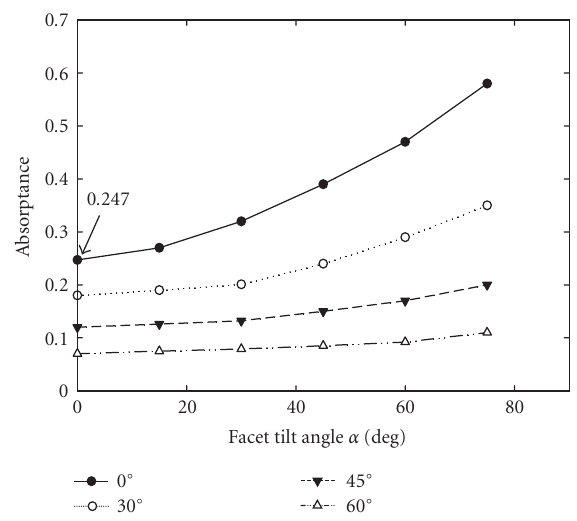
Figure 3: The relation among absorptance, h and photon’s incidence angle θ .